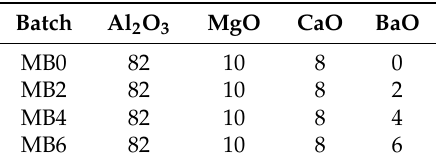
Table 1. Chemical composition of Al 2 O 3 -MgO-CaO-BaO system, wt. %. Batch Al 2 O